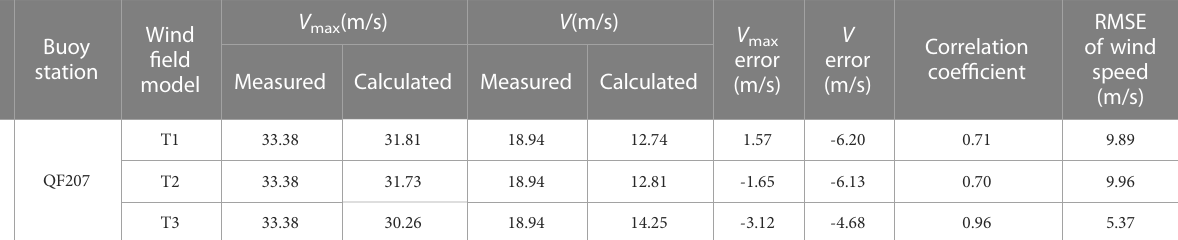
TABLE 1 Wind speed simulation and buoy station measured values.